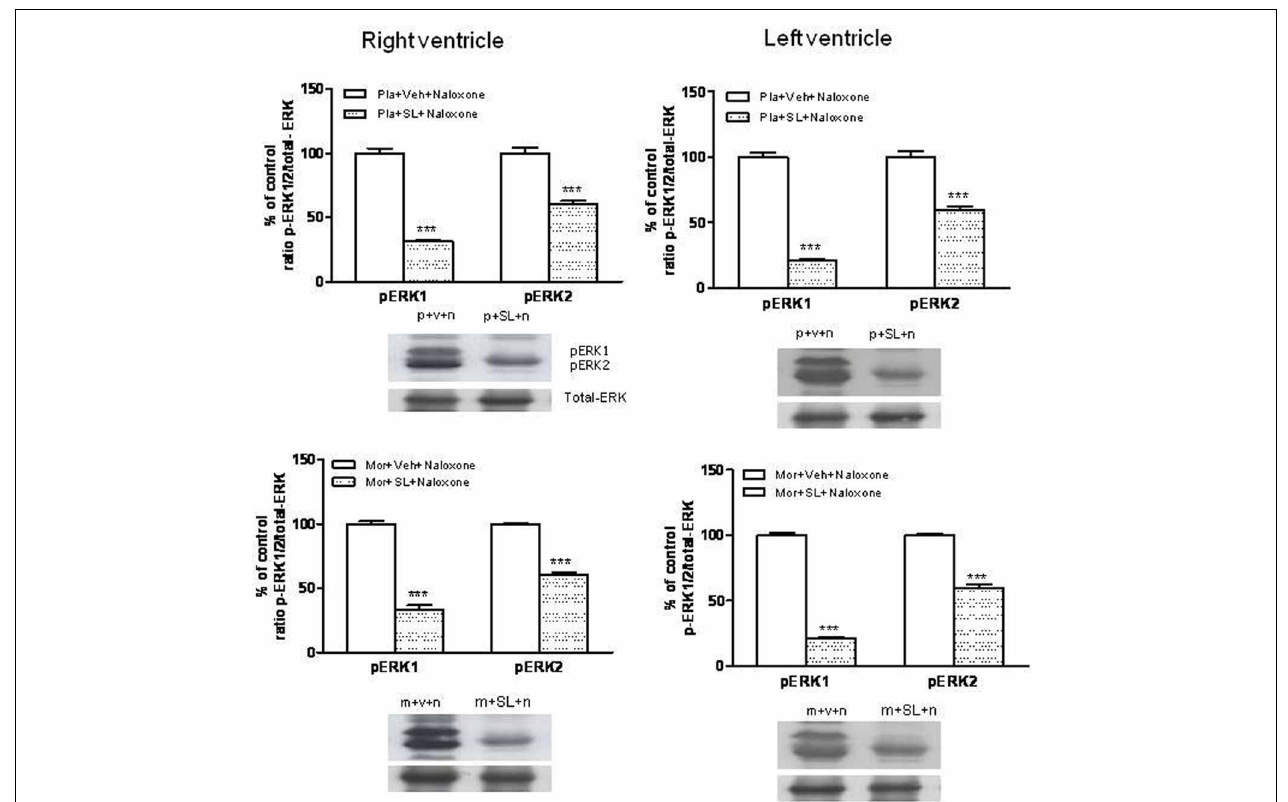
FIGURE 7 | Inmunoblots of ERK1/2 in the right and left ventricles isolated from placebo (pla,p)- or morphine (mor, m)-dependent rats after subcutaneous administration of naloxone (n) in rats treated with SL327 (SL, 100mg/kg, i.p.) or vehicle (veh, v), 1h before naloxone injection. Phospho (p)ERK1 and pERK2 immunoreactive bands were